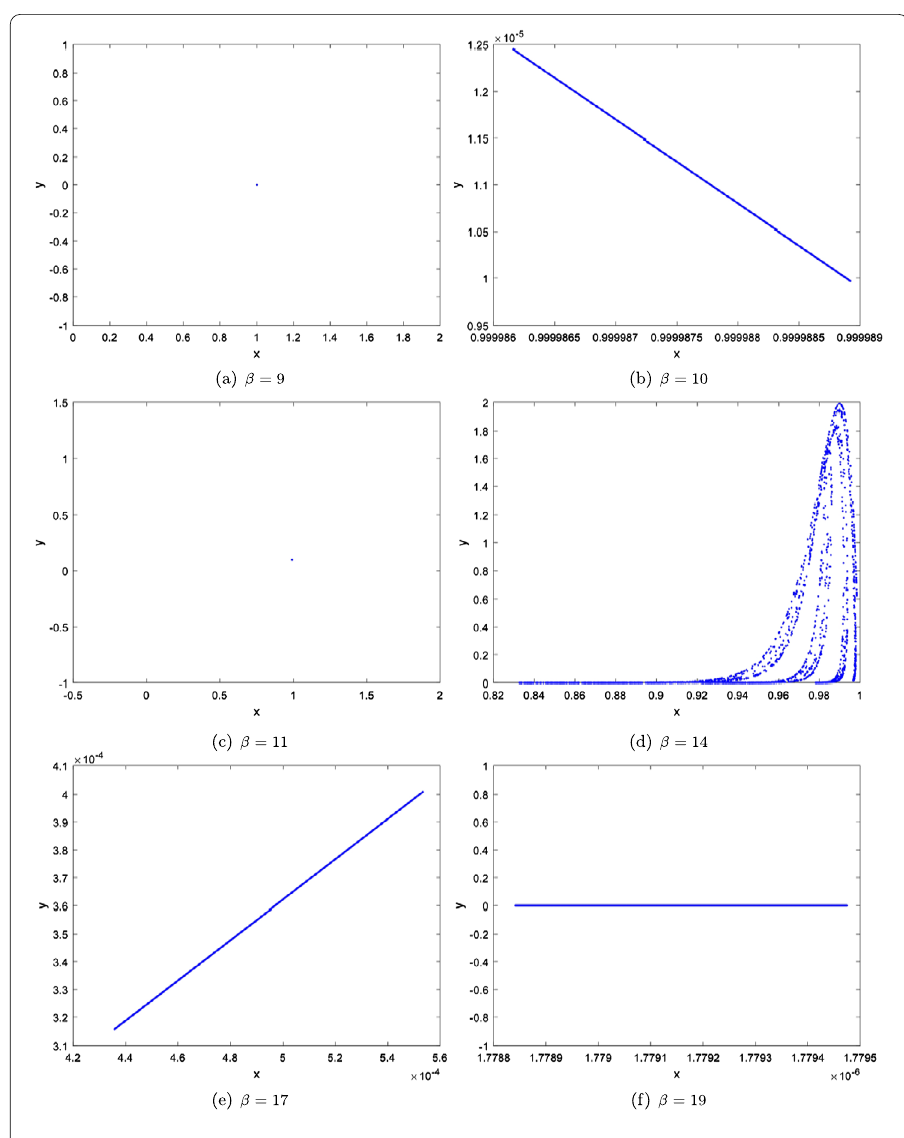
Figure 3 Phase portrait of the system (1.5) versus